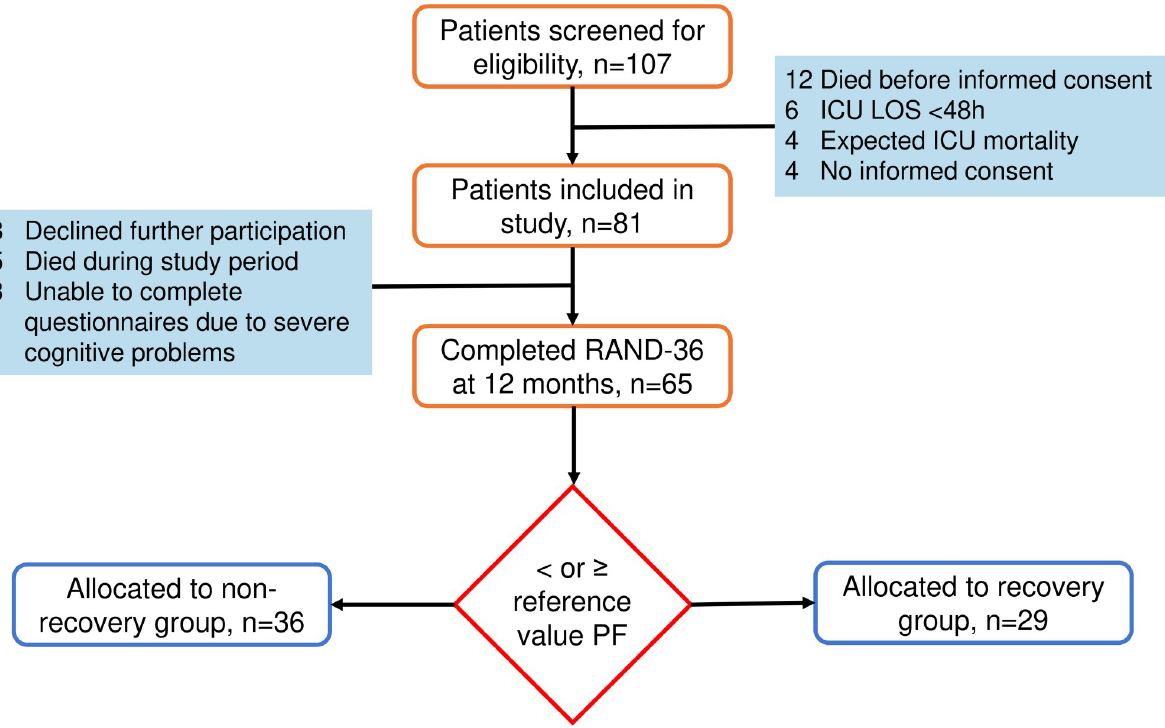
Fig 1. Flowchart study inclusion and group